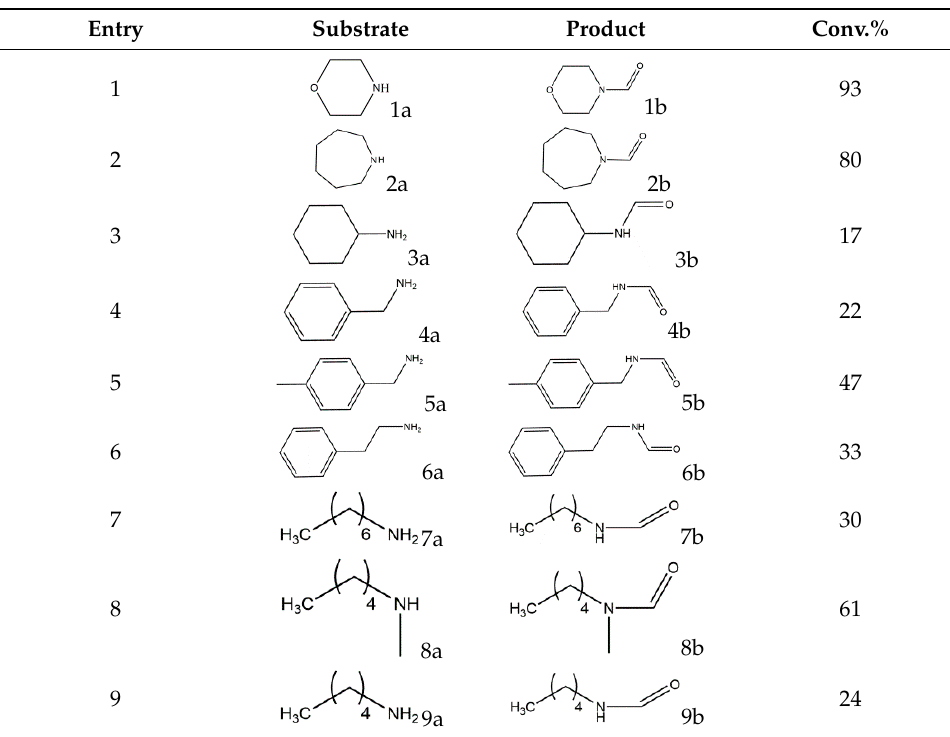
Table 3. Substrate prolongation experiments of the Pd@POPs catalyst.